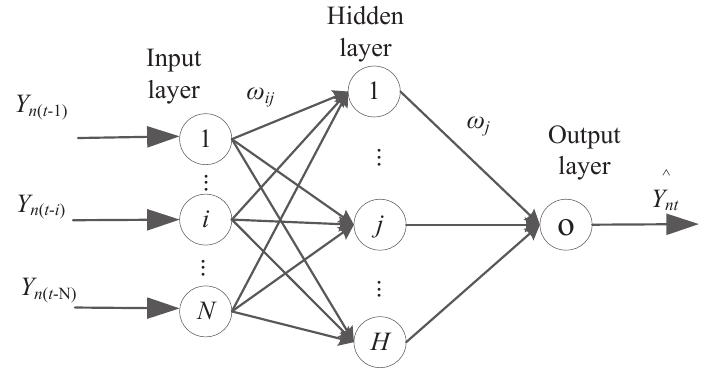
Figure 1. Schematic diagram of